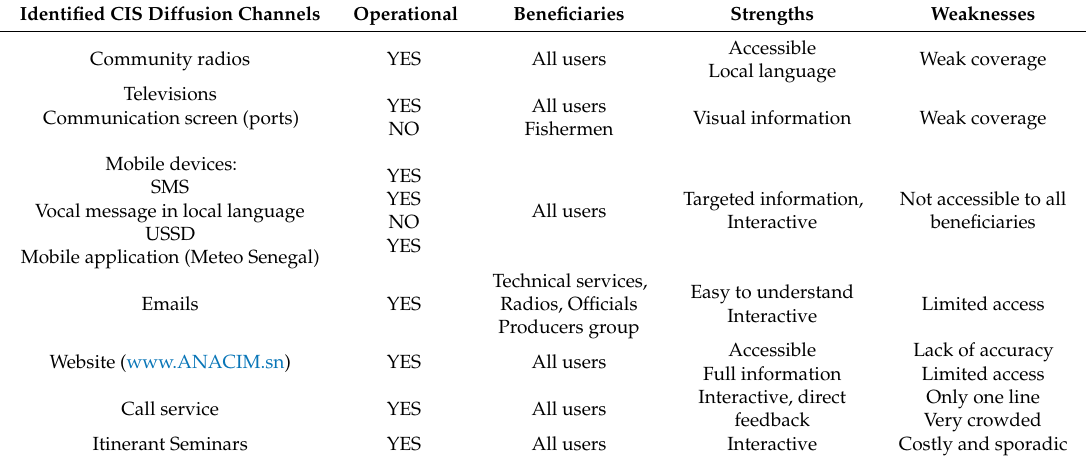
Table 2. Channels developed for CIS transmission (source: from authors).